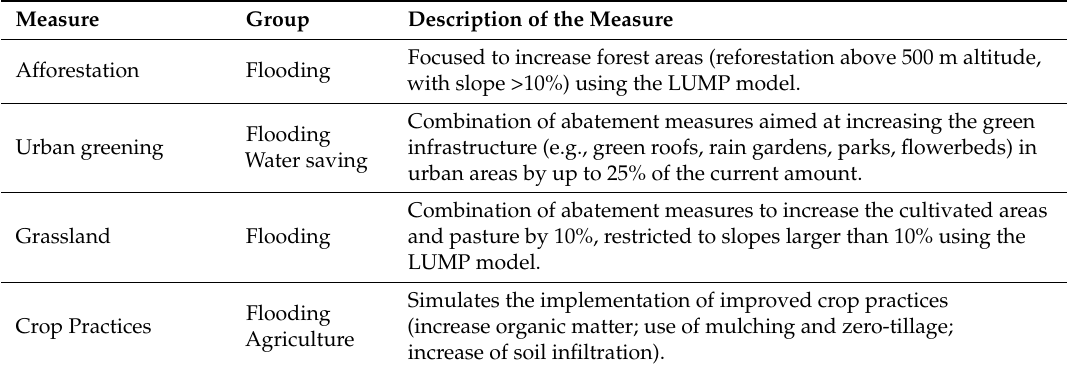
Table 1. Short description of the measures considered in the Blueprint. Group on each measure is included according to the type of effect that is expected to